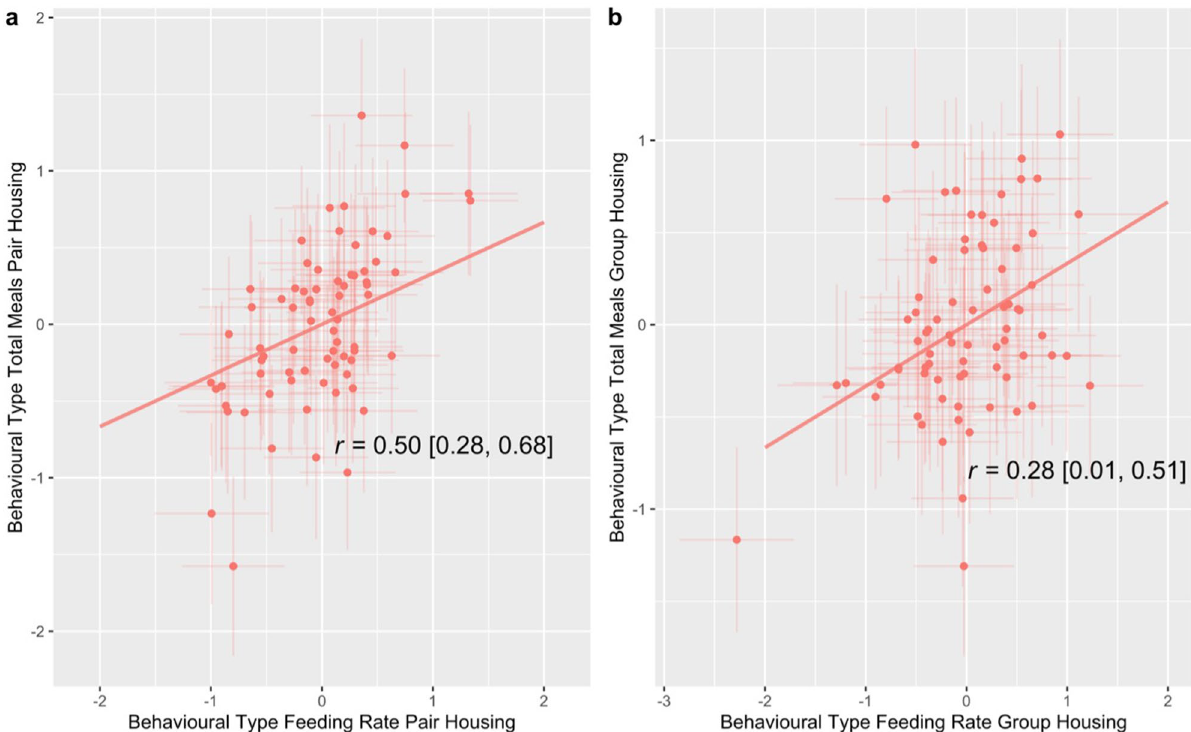
Figure 2. Visual representation of the line of best fit of the individual correlation (r) for feeding rate and meal frequency behavioural types within contexts. The credibility intervals are shown in square brackets. Panel ( a ) reports the correlation for feeding rate and meal frequency behavioural types in the pair housing and panel ( b ) reports the correlation for feeding rate and meal frequency behavioural types in the group housing. Posterior means and 95% credible intervals of estimates behavioural types are shown. The values on the x and y axes represent estimates for behavioural types which were calculated from the scaled response variables in the